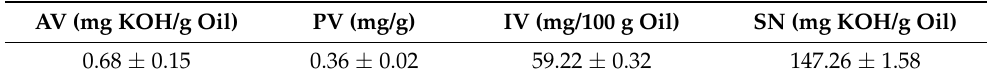
Table 4. Characteristic value of vanilla essential